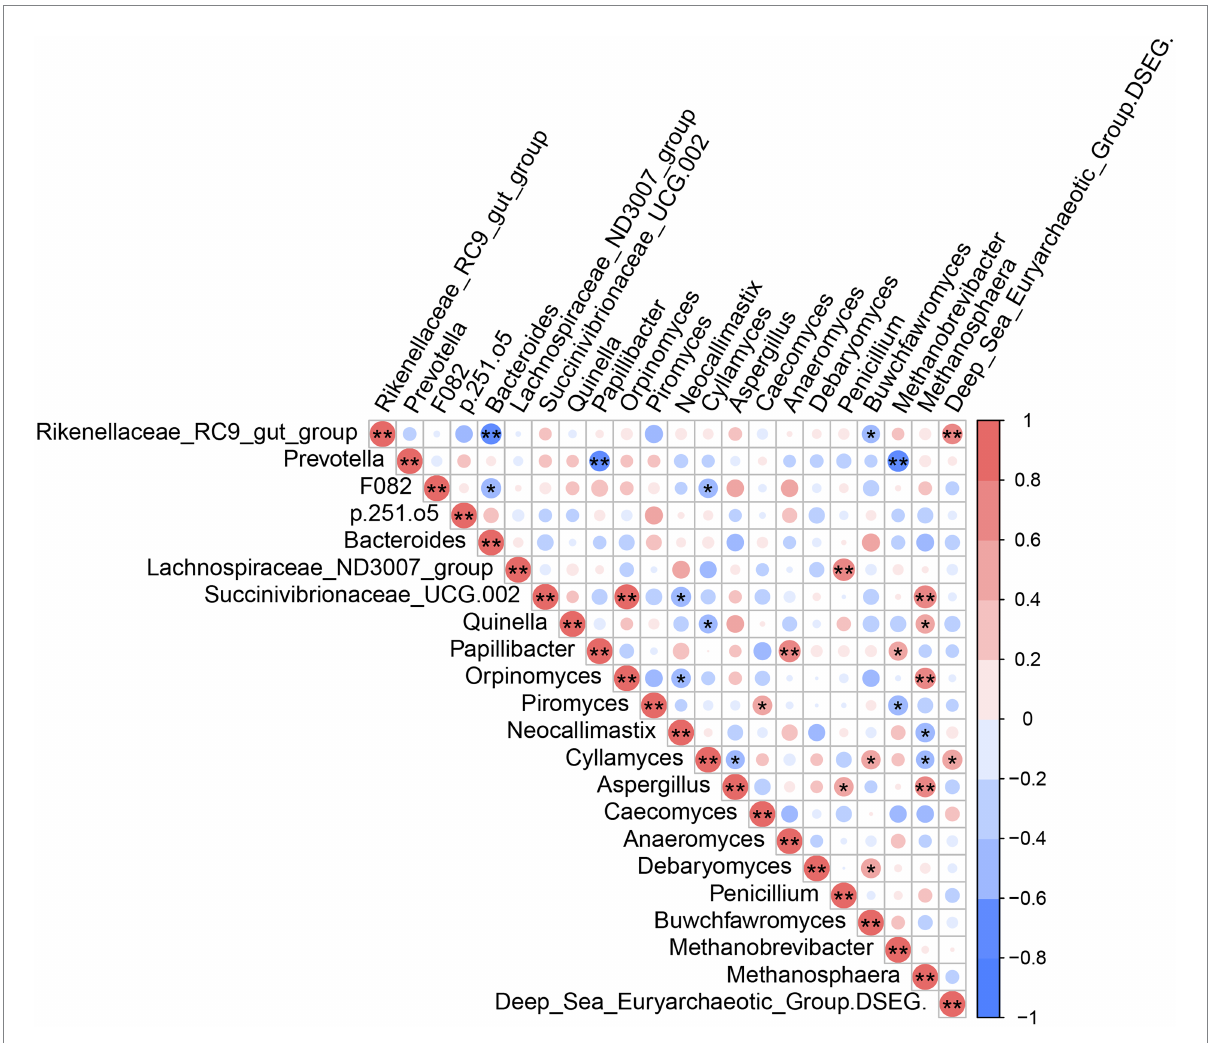
FIGURE 6 Mutual-correlation among the higher abundant genera of rumen microbial. Red color represents a positive correlation, while blue represents a negative correlation. * p < 0.05, ** p <